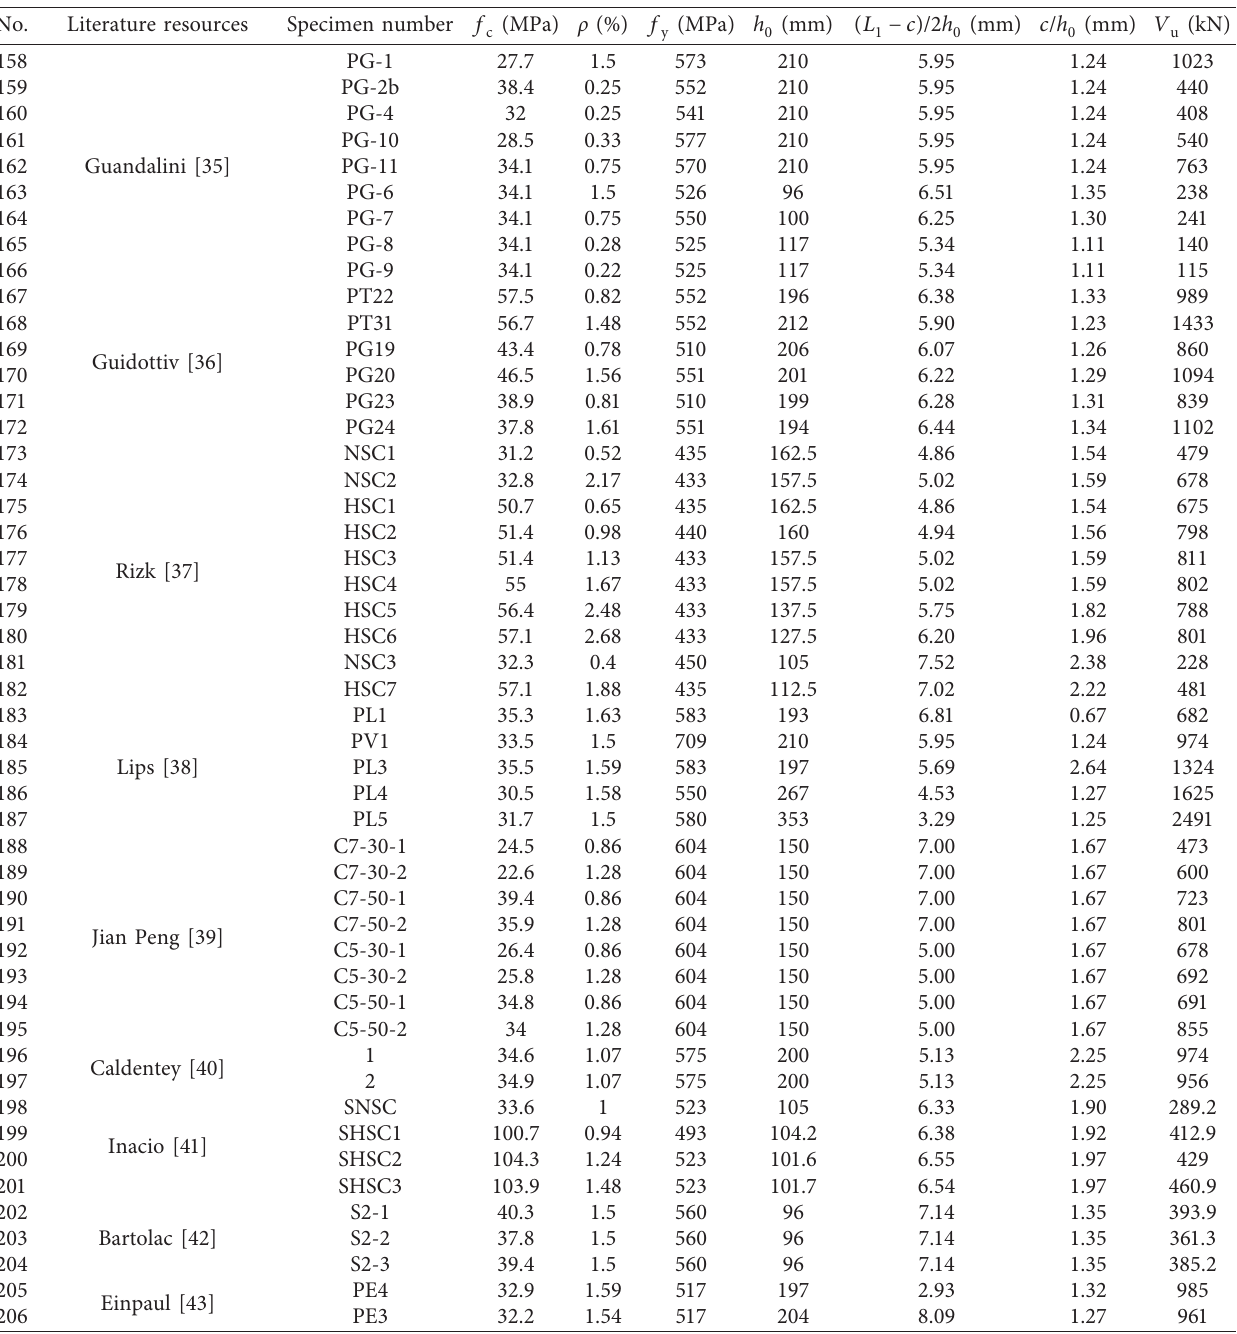
Table 2: Conversion relationships of concrete strength ( f